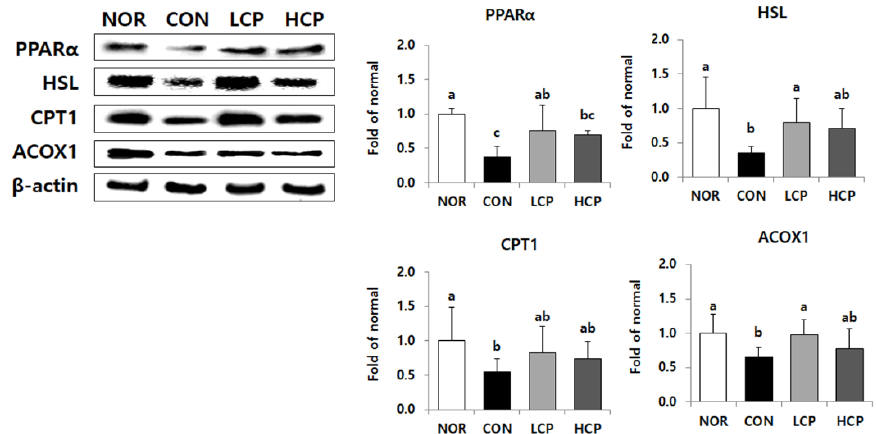
Figure 8. Effects of two skate skin-derived collagen peptides with different molecular weights on protein expression of lipolysis-related molecules in adipose tissue. Data are mean ± standard deviation (SD) ( n = 10 per group). Experimental groups were divided into four groups; m/m mice were orally administered water as a vehicle (NOR group) whereas db/db mice were orally administered water (control group, CON), LCP (LCP group), or HCP (HCP group) at a dose of 200 mg·kg bw −1 ·day −1 for 8 weeks. a–c Different letters mean significant differences to one-way analysis of variance (ANOVA), followed by Duncan’s multiple-range test at p < 0.05.